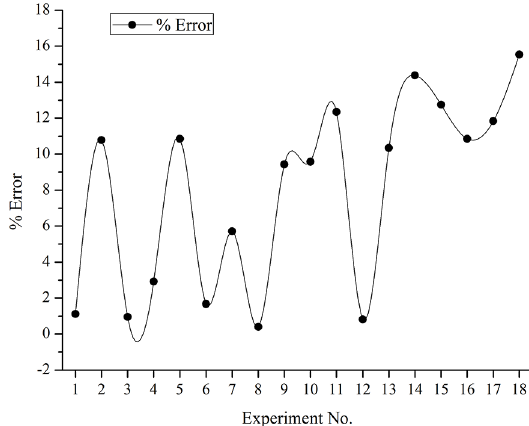
Figure 9. Percent error in measured and predicted results of W